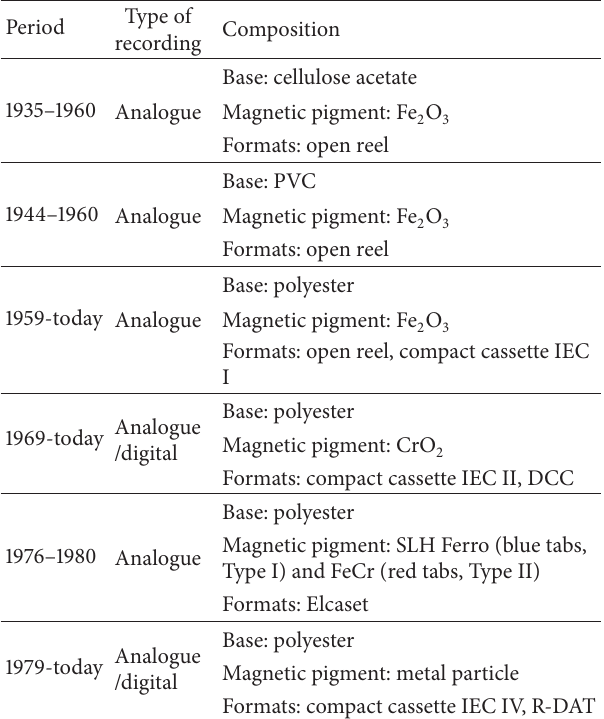
Table 2: Types of magnetic tape